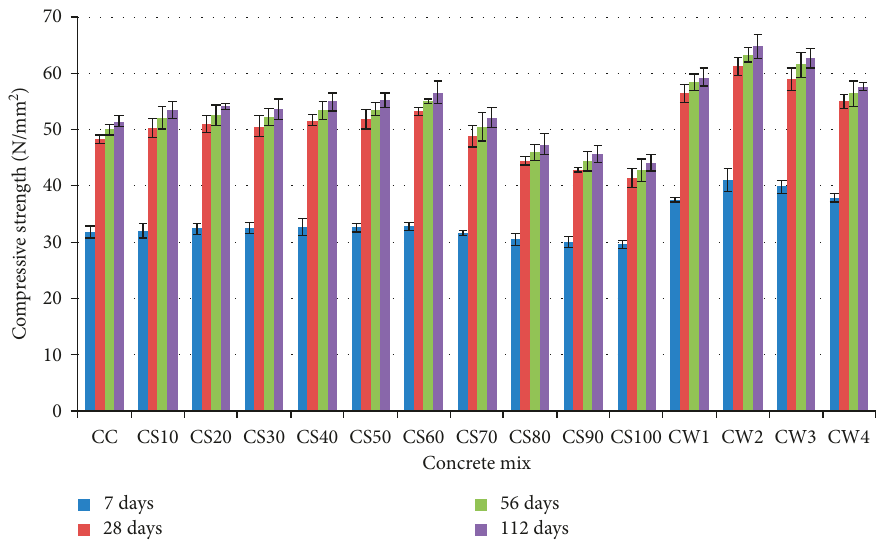
Figure 2: Compressive strength of concrete mixes at different curing